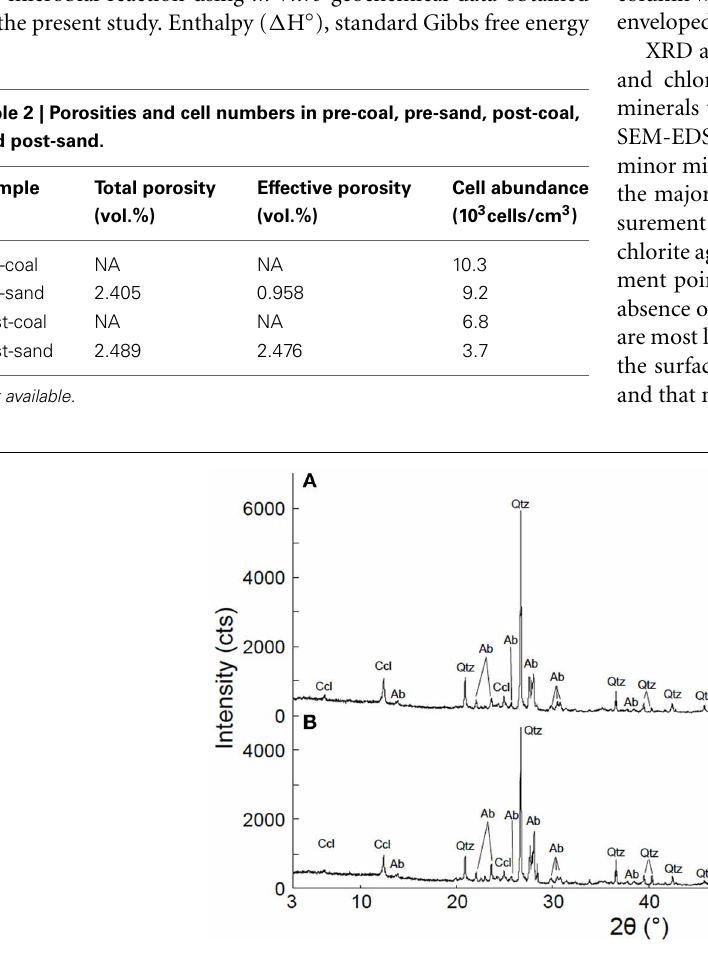
FIGURE 3 | Result of XRD analysis. (A) XRD pattern of pre-sand. (B) XRD pattern of post-sand. Qtz, quartz; Ab, albite; Ccl,